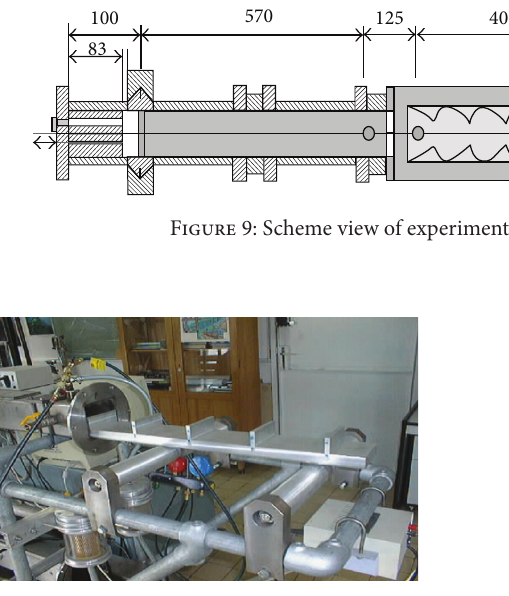
Figure 10: The photo of the channel with obstacles